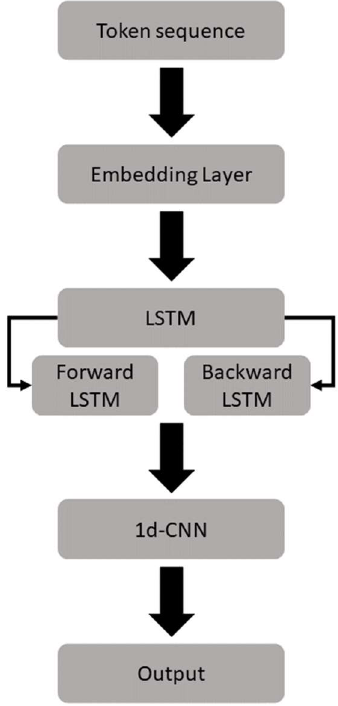
Figure 5. Deep neural network structures used in deep learning-based approach.